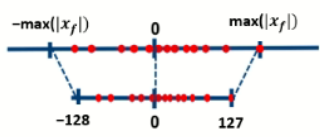
Figure 5. This figure shows the mapping of the input tensor float range to the 8-bit signed integer quantized range in symmetric